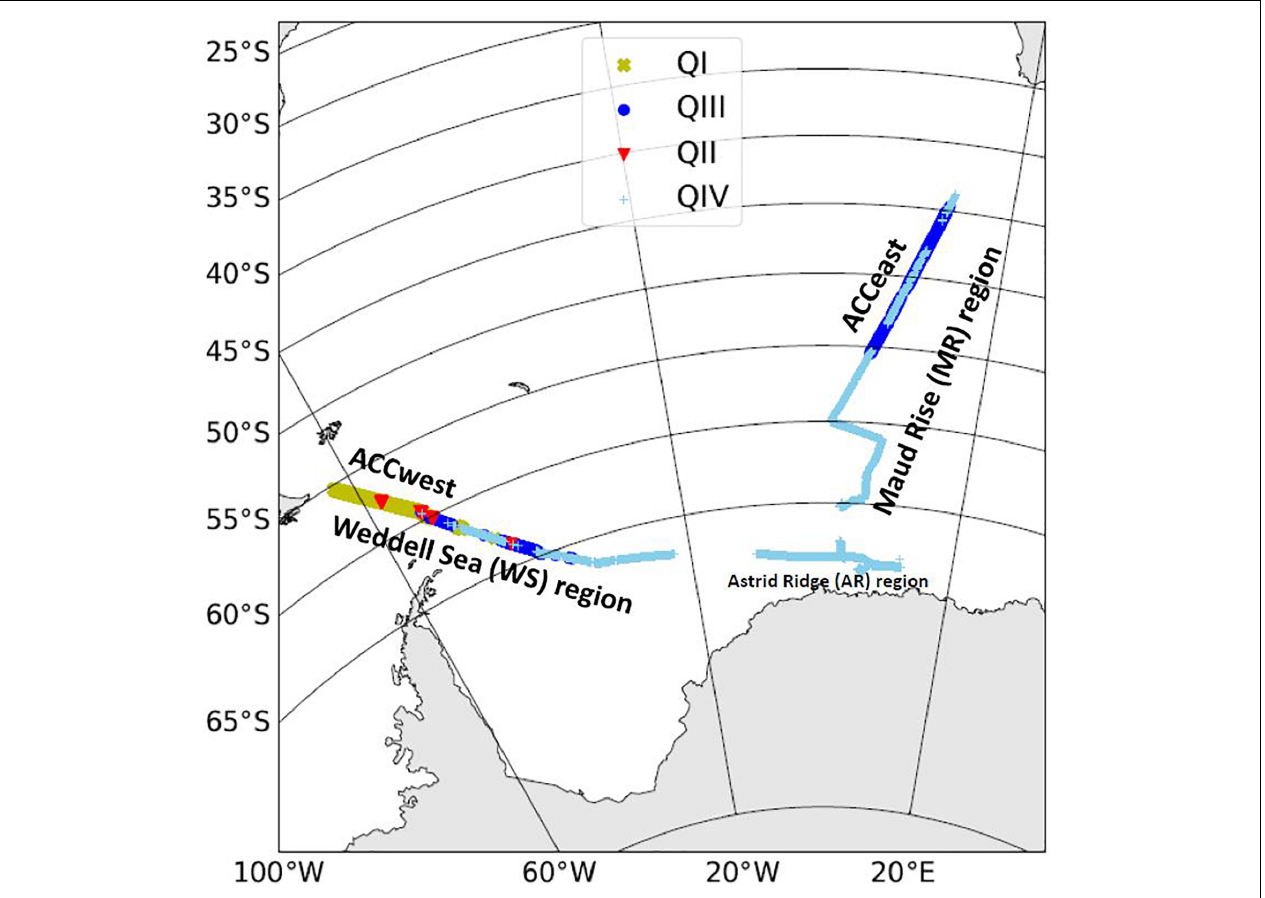
FIGURE 6 | The spatial distribution of observations in the quadrants from the correlation model. Yellow = observations in the QI, Red = observations in QII, Deep blue = observations in QIII, and Sky blue = observations in QIV.